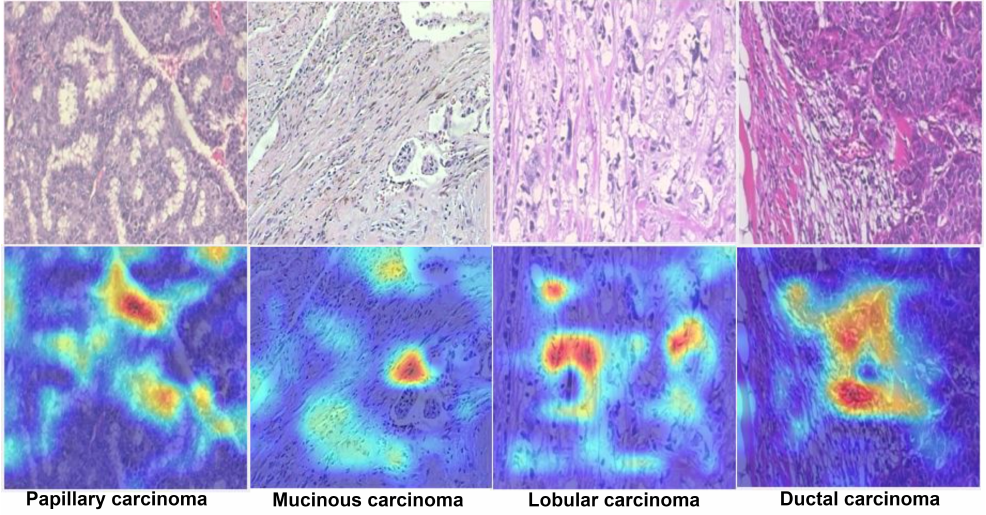
Figure 16. Sample of regions of interest generated by Grad-CAM (top = malignant subtypes original images, bottom = malignant Grad-CAM